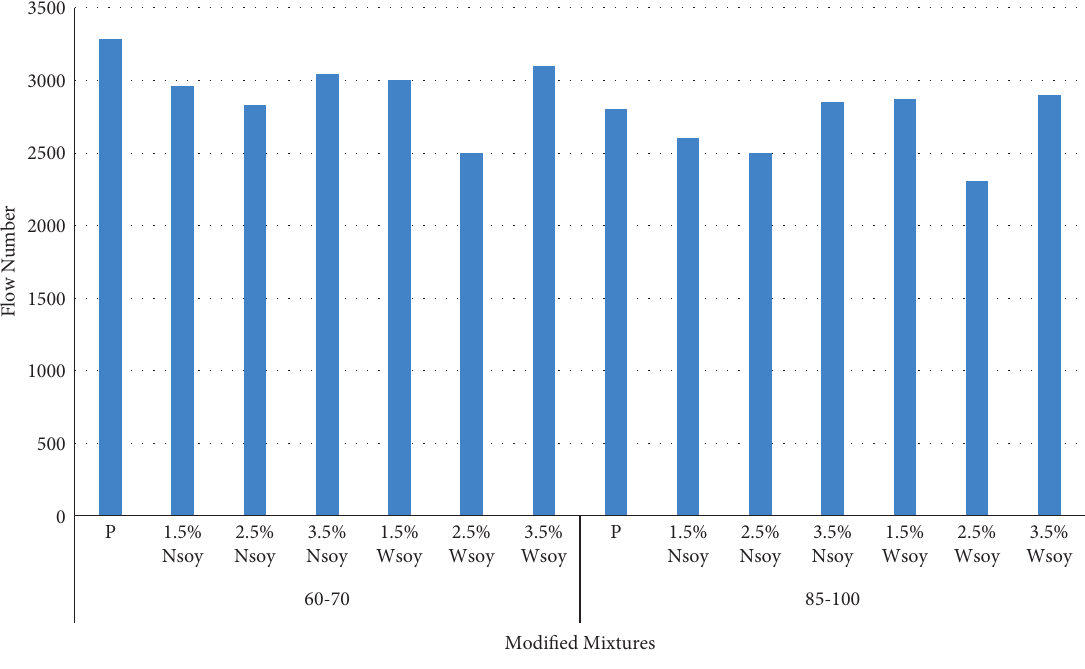
Figure 10: Unmodified and modified mixtures’ flow number.